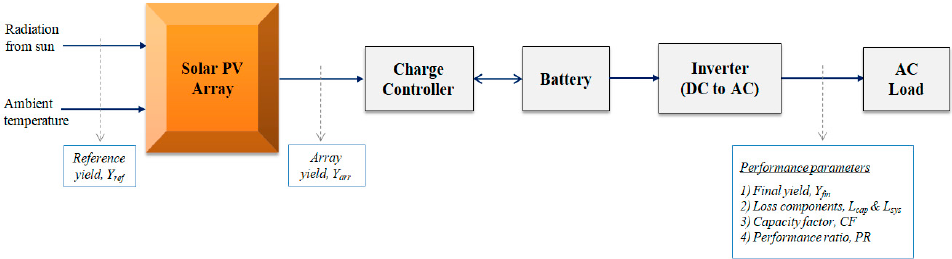
Figure 10. Specifications of the polycrystalline PV array used in the proposed configuration are in Table 2.